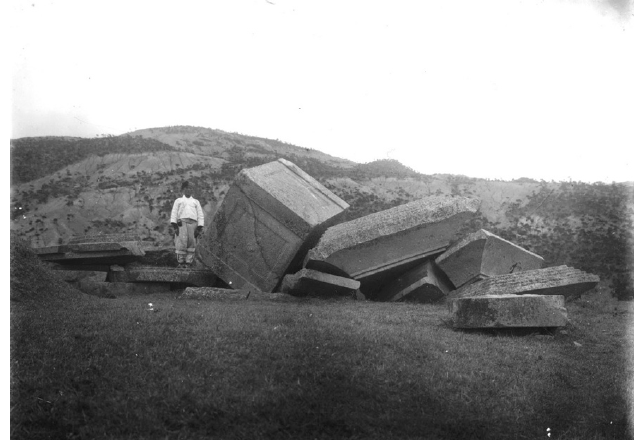
Figure 4. Broken pagoda at Ch’angnimsa site, Mount Nam. Gelatin dry plate from the colonial period. Courtesy of National Museum of Korea.